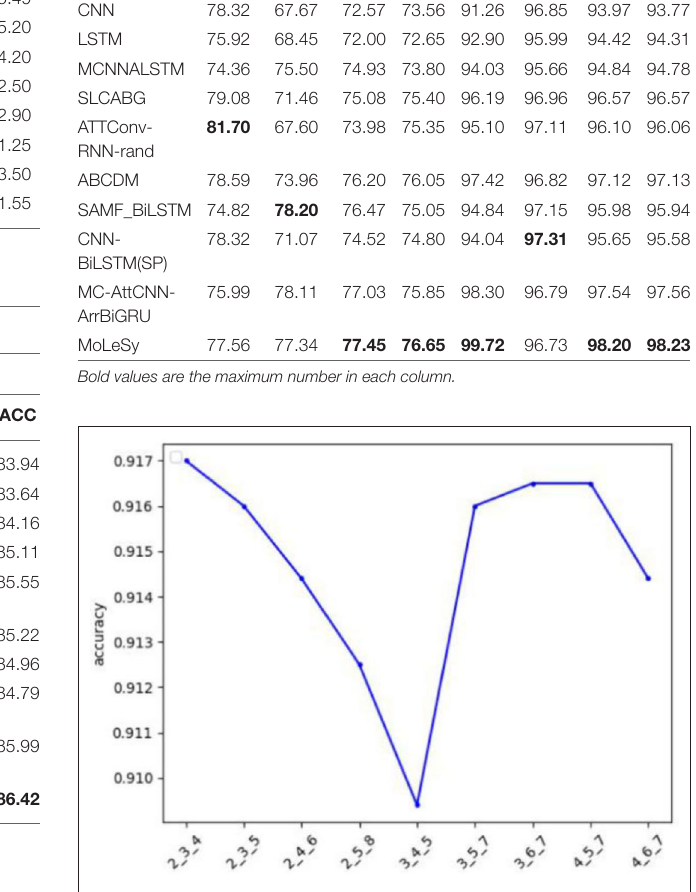
FIGURE 5 | The influence of different kernel sizes on the Hotel data set.